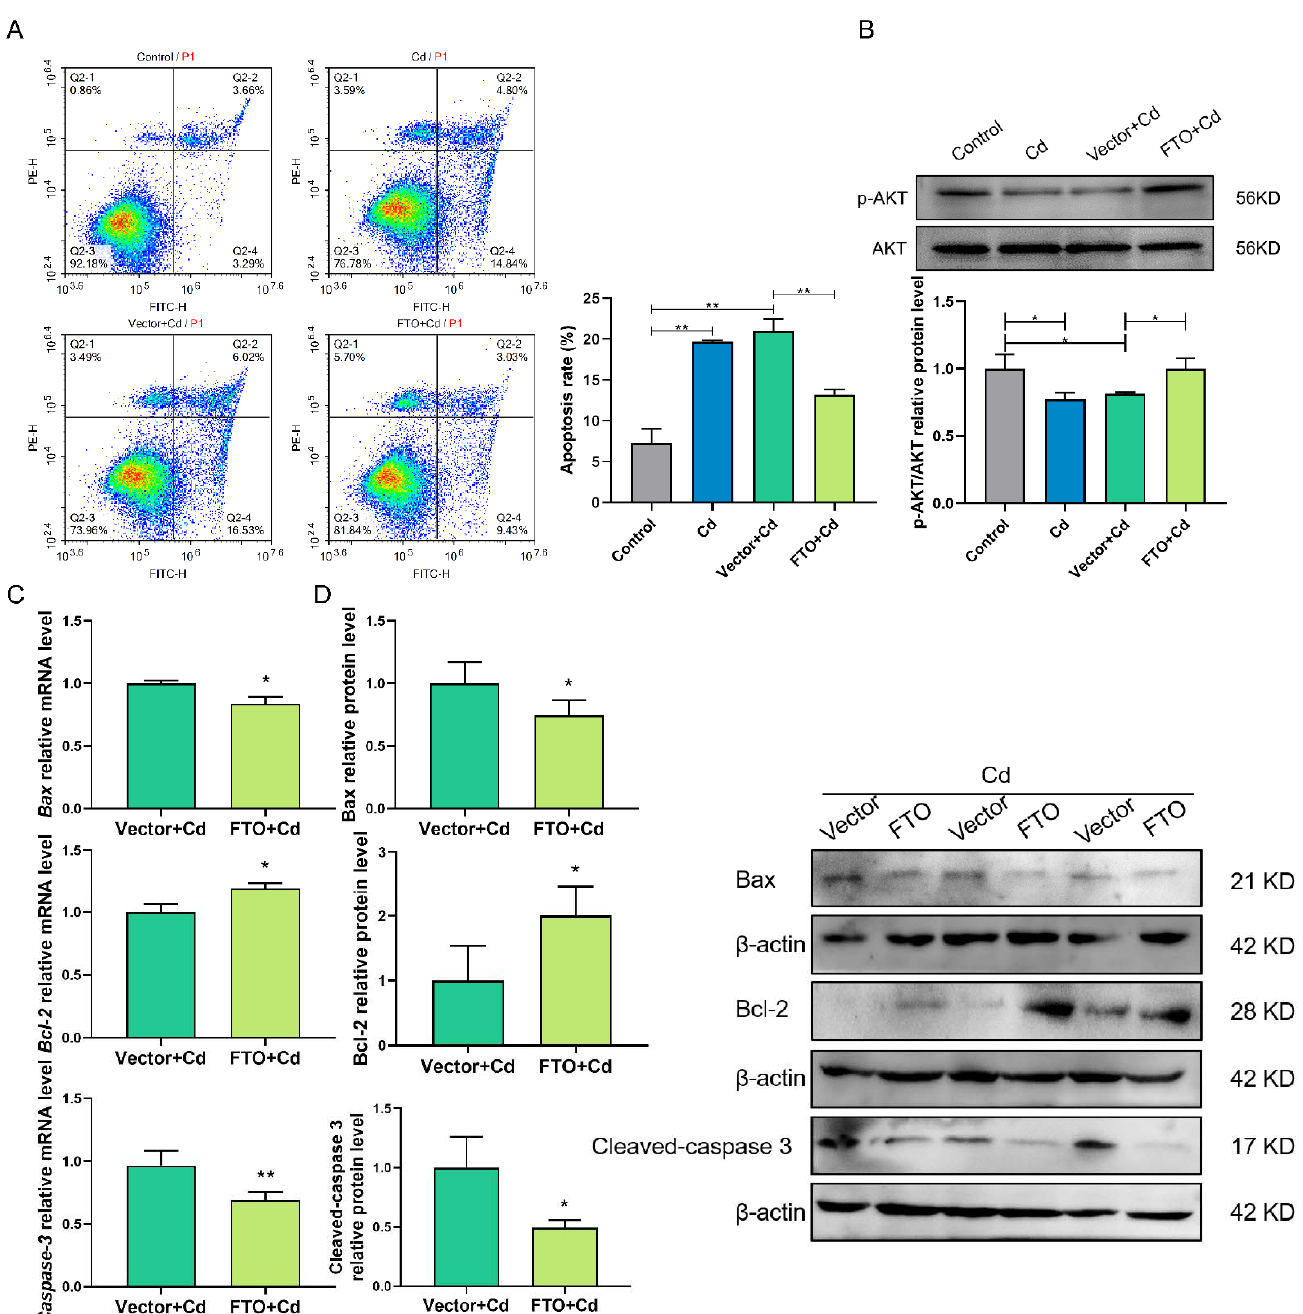
Figure 6. FTO overexpression suppressed Cd ‐ induced apoptosis, perhaps by activating the AKT pathway in granulosa cells. ( A ) Flow cytometry analysis results detected apoptosis rate in the control, Cd, Vector + Cd, and FTO + Cd groups. ( B ) The p ‐ AKT protein levels were analyzed by Western blotting after Cd and FTO treatments. ( C , D ) RT ‐ qPCR and Western blotting results indicated the mRNA and protein levels of Bax, Bcl ‐ 2, and caspase ‐ 3 after FTO overexpression. * p < 0.05; ** p < 0.01. 2.7. FTO Overexpression Suppressed Cd ‐ Induced Oxidative Stress The role of FTO in Cd ‐ induced oxidative stress was assessed. RT ‐ qPCR indicated that increasing FTO expression increased the transcriptional levels of CAT , SOD , and NQO1 ( p < 0.01; Figure 7A–C) and significantly increased the intracellular levels of CAT, SOD, and NQO1, which was accompanied by a decrease in the level of MDA ( p < 0.05; Figure 7E–H). Further analysis using flow cytometry analysis (DHE) showed that FTO overex ‐ pression reduced the levels of intracellular ROS ( p < 0.05; Figure 7I). These might be